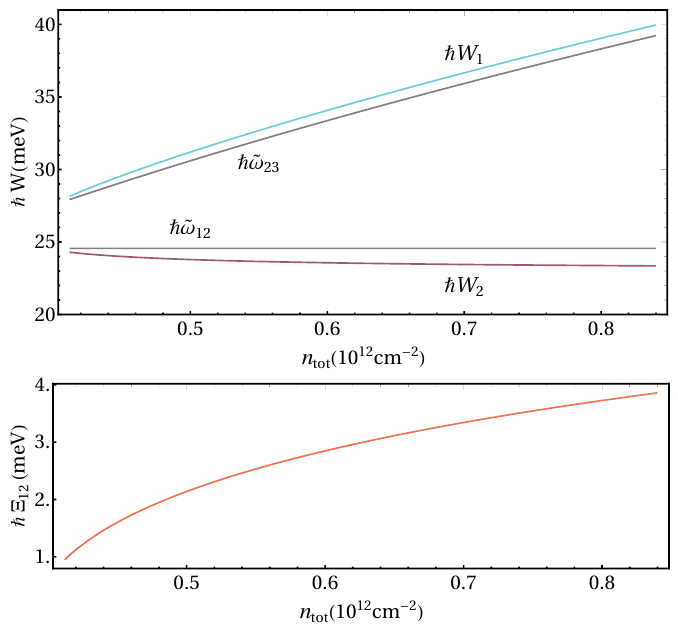
Figure 2. (Color online) Top : Bare intersubband plasmon energy without interactions (¯ h ˜ ω 12 and ¯ h ˜ ω 23 ) and coupled eigenmodes (¯ hW 1,2 , in purple and blue) as a function of the total doping density n tot . Bottom : Coupling strength between the two individual intersubband plasmons as a function of the total electronic